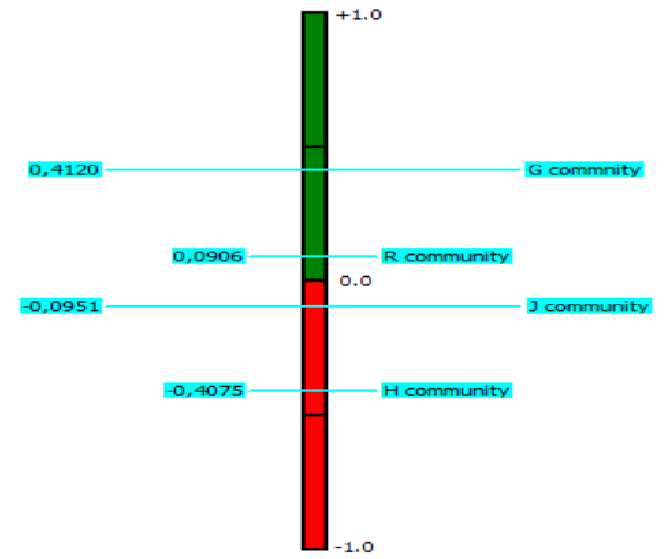
Figure 2. Net flow ranking chart of the four communities for resilience adapted to FFE.